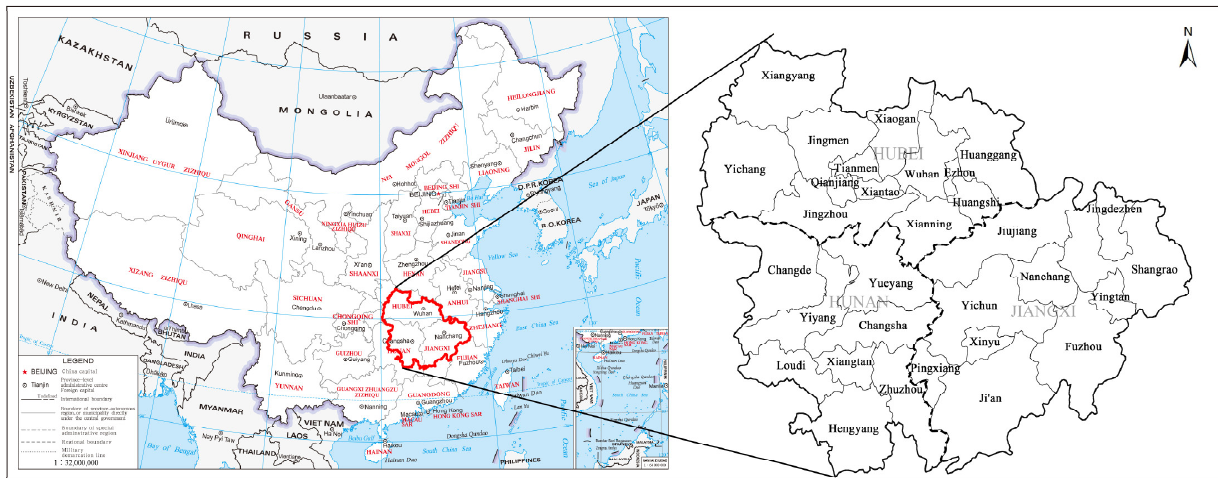
Figure 2. Urban agglomerations in the middle reaches of the Yangtze River.